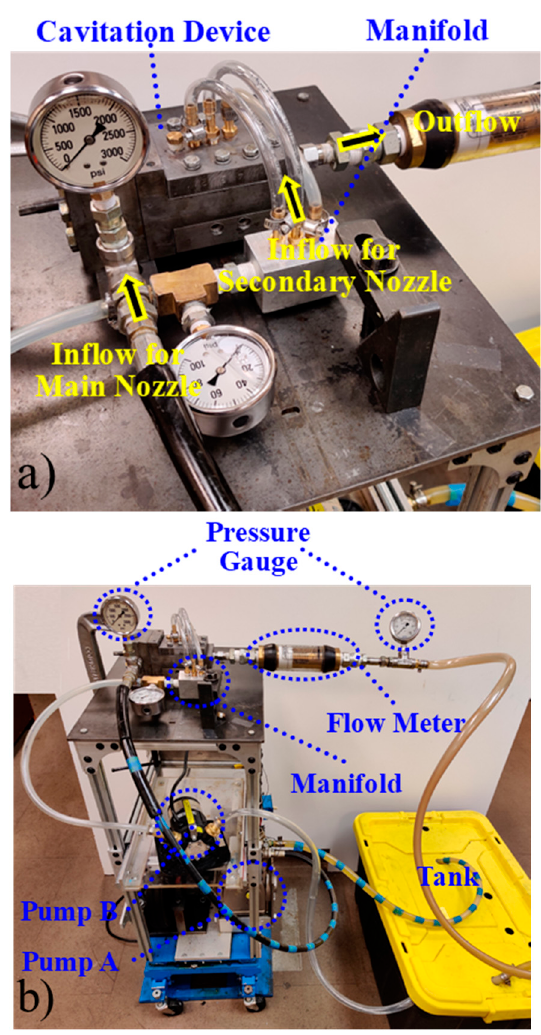
Figure 10. Experimental setup ( a ) Enlarged top view of the setup, ( b ) Overall setup